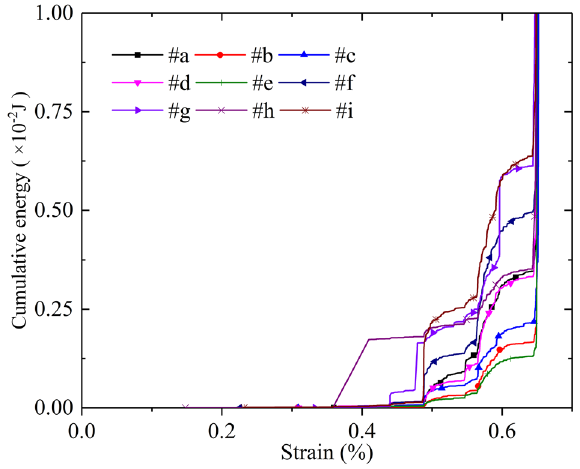
Figure 9. The variation of simulated cumulative energy at AE sensors #a ~ #i versus axial strain by PVBM.